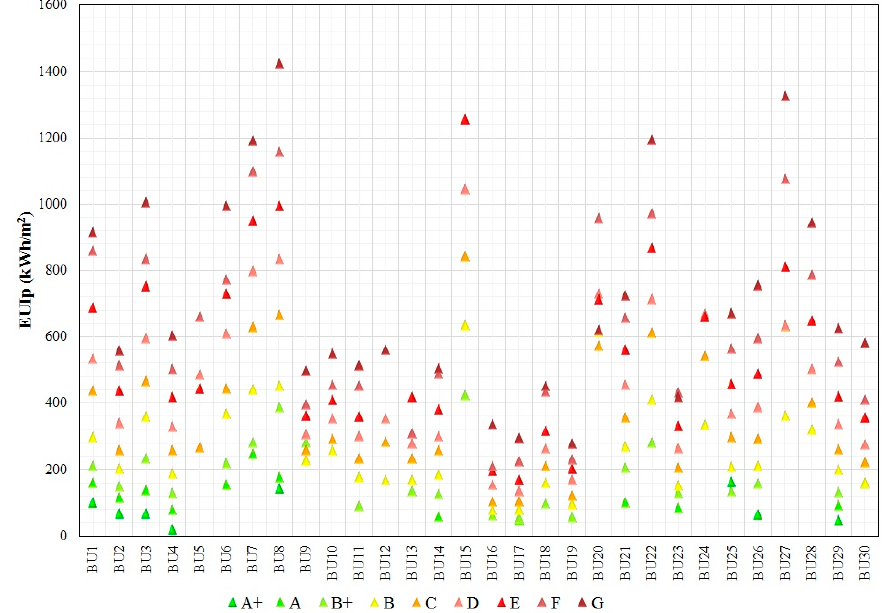
Figure 8. Calculated average primary energy use intensity per energy class (from A+ to G) for the various building uses (1 to 30, defined in Table 1).